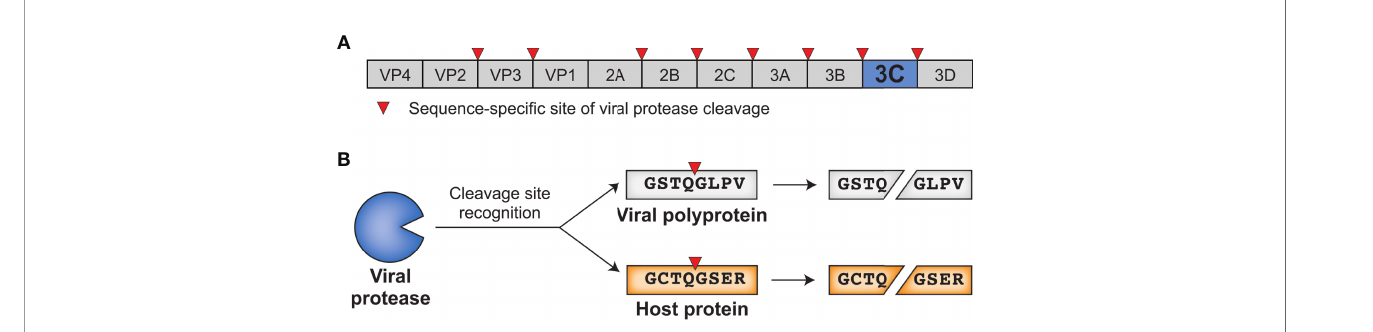
FIGURE 1 | Viral proteases cleave speci fi c sites within the viral polyprotein and host proteins. (A) Schematic of an enterovirus (family: Picornaviridae ) polyprotein, with the position of the 3C protease and sites of 3C-mediated cleavage shown. (B) 3C protease recognizes and cleaves viral polyprotein sites and host proteins with the same sequence speci fi city.